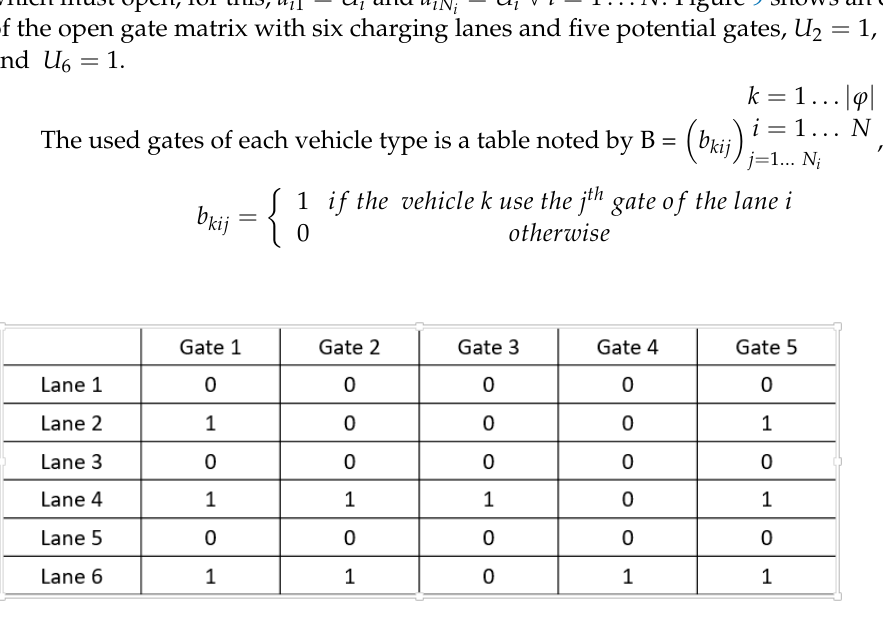
Figure 9. Example of the open gate matrix .